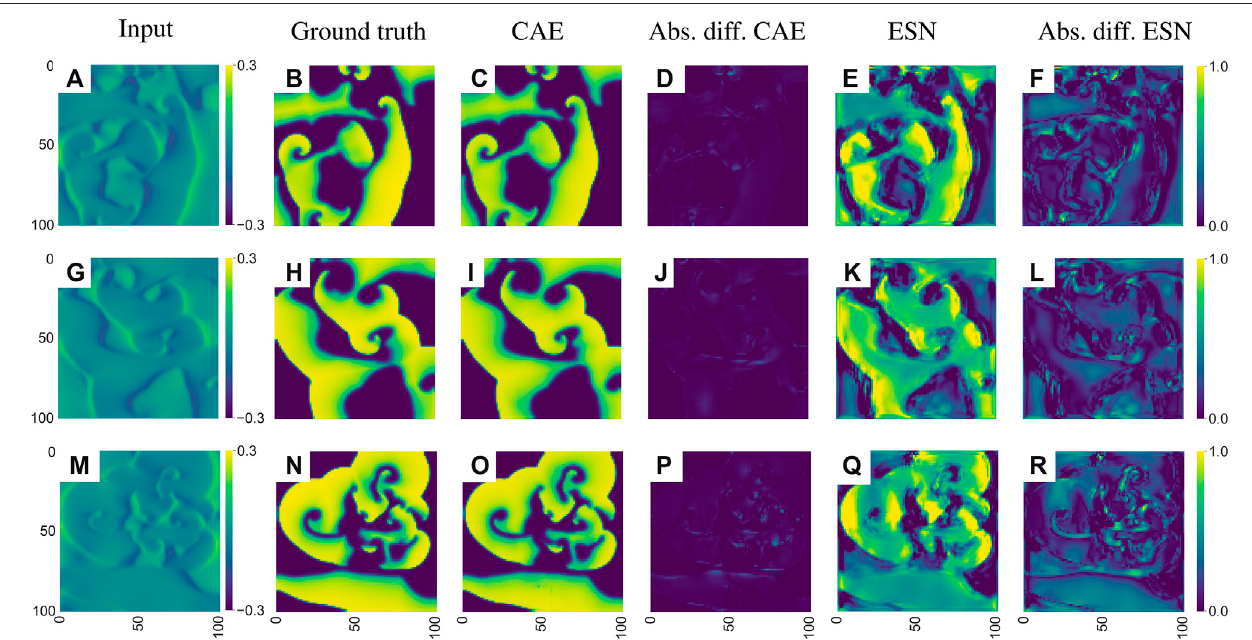
FIGURE 14 | Exemplary visualization of the input and output for both networks for the inverse reconstruction of the membrane voltage u Eq. (4) based on the mechanical deformation Δ A Eq. (13) . (A) – (F) corresponds to t (cid:2) 1 , 000, (G) – (L) to t (cid:2) 1 , 500 and M-R to t (cid:2) 2 , 000 of the test data set. The input is the mechanical deformation given by Eq. (13) caused by the electrical potential u from Eq. (4) .